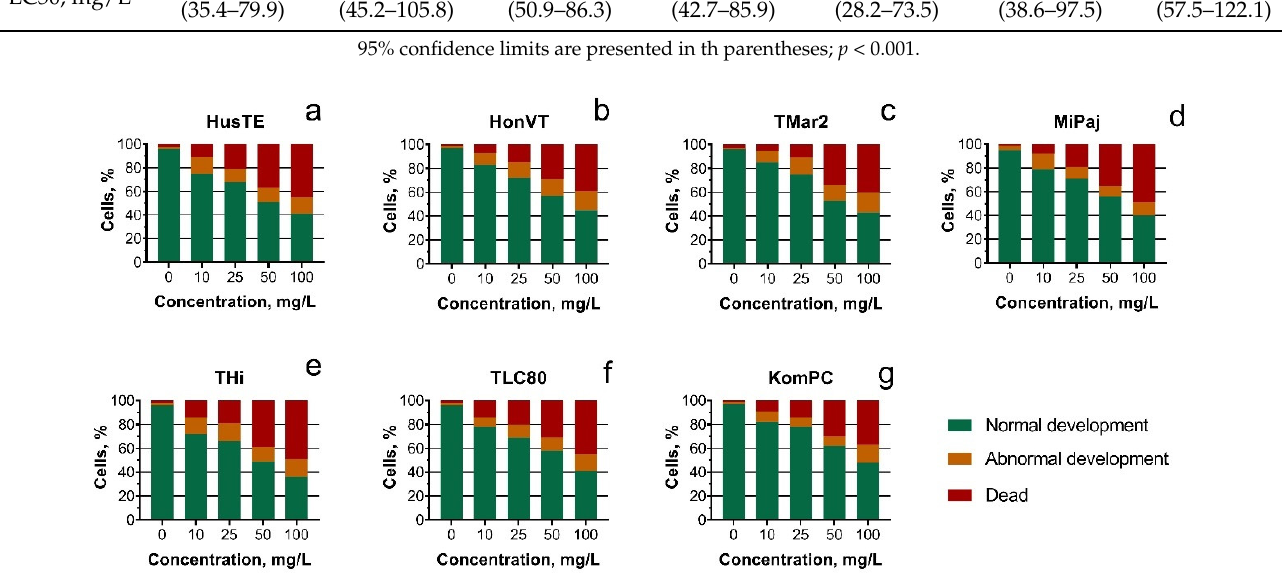
Figure 6. The state of S. intermedius embryo development after 24 h of the exposure to the tested VEP samples: ( a ) HusTE; ( b ) HonVT; ( c ) TMar2; ( d ) MiPaj; ( e ) THi; ( f ) TLC80; ( g ) KomPC. Table 5. Mean calculated LC50 values of embryo mortality of the sea urchin S. intermedius after 24 h of exposure to the VEPs. Sample